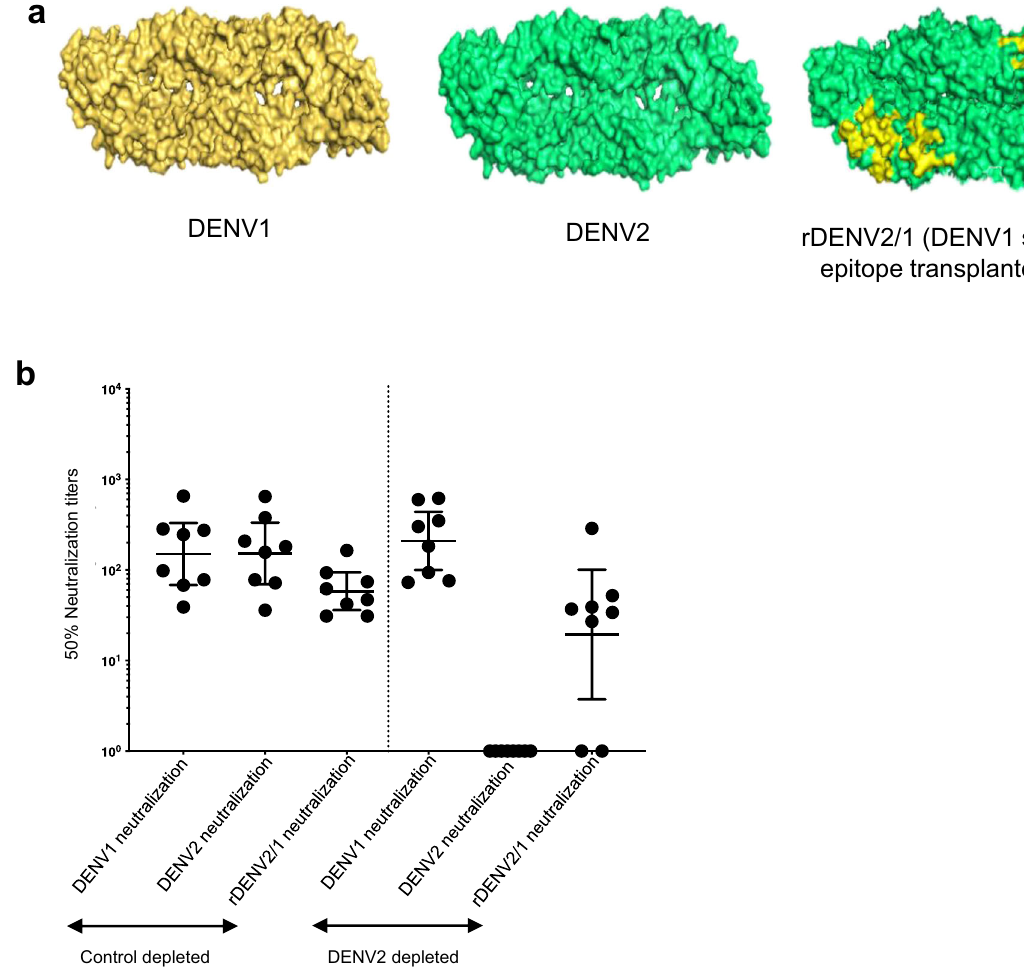
Fig. 5 TV003 induce varying levels of DENV1 serotype-speci fi c responses against a known DENV1-neutralizing epitope. a DENV1wt (yellow), DENV2wt (green), rDENV2/1 with DENV1-speci fi c 1F4 mAb epitope transplanted into DENV2 (shown in yellow) are depicted. b Panel of 8 TV003 sera ( n = 8) with evidence of DENV1 TS responses were subjected to depletions against DENV2 to map the DENV1 TS nAb epitopes using the rDENV2/1 virus. Figure shows the 50% nAb titers for the BSA (control) depleted and the DENV2 depleted serum samples against DENV1 wt, DENV2 wt and the rDENV2/1 viruses. Data were analyzed from a total number of eight subjects indicated as dots from a single independent experiment and expressed as geometric mean titers ± 95% con fi dence intervals of the grouped samples ( b